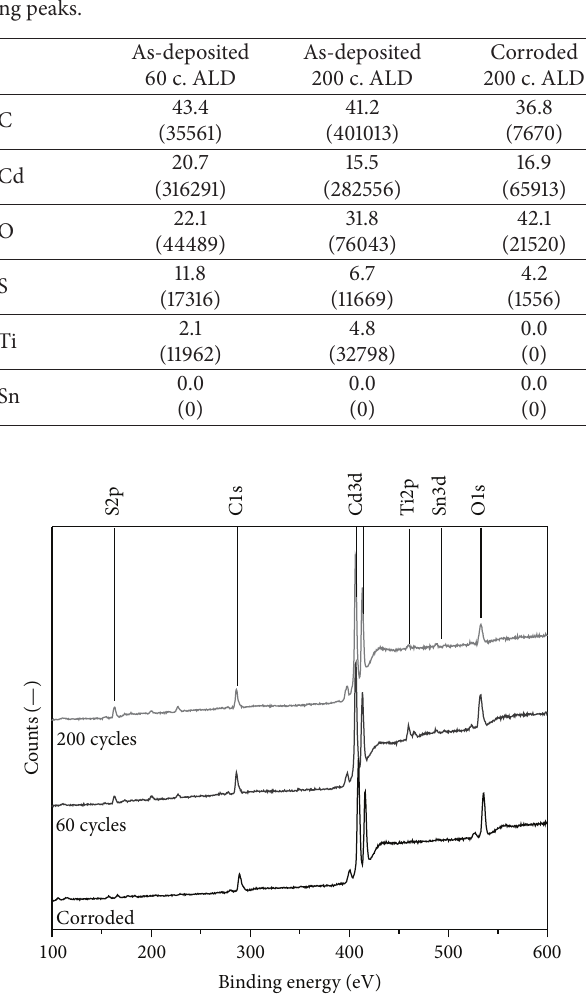
Figure 8: XPS spectra of a fully corroded sample that was originally coated with 200 cycles of ALD (1) and as-deposited samples with 60 (2) and 200 (3) cycles of ALD. The vertical lines indicate the most prominent element peaks. The spectra are offset for clarity.